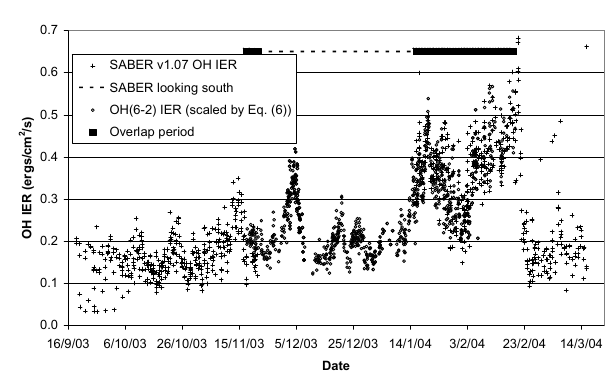
Fig. 6. Integrated emission rates (IER) calculated from SABER pro- files at Longyearbyen (78 ± 5 ◦ N, 16 ± 10 ◦ E) together with OH(6-2) IERs measured by the Ebert-Fastie during 2003–2004 season. The OH(6-2) IER values have been scaled according to the relationship illustrated in Fig.